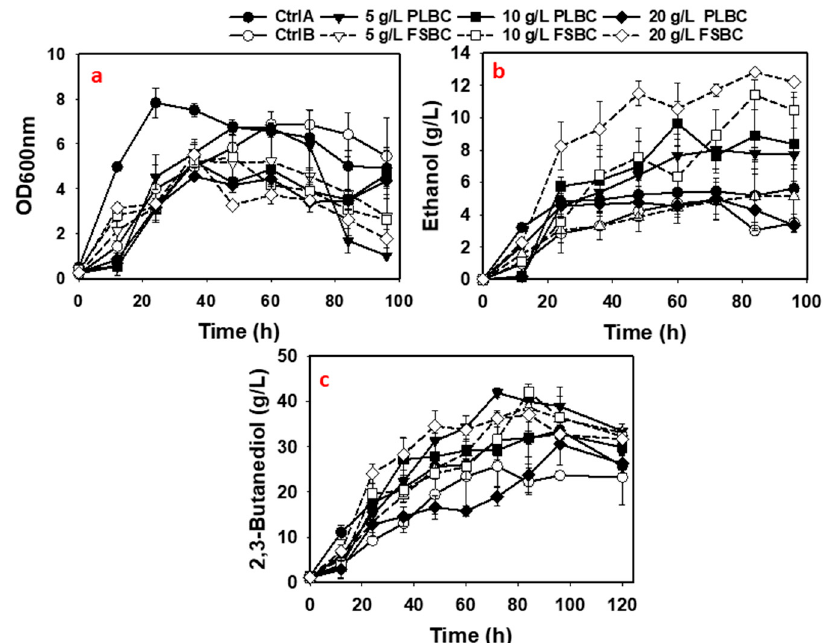
Figure 3. The fermentation profiles of P. polymyxa cultures supplemented with 5–20 g/L PLBC